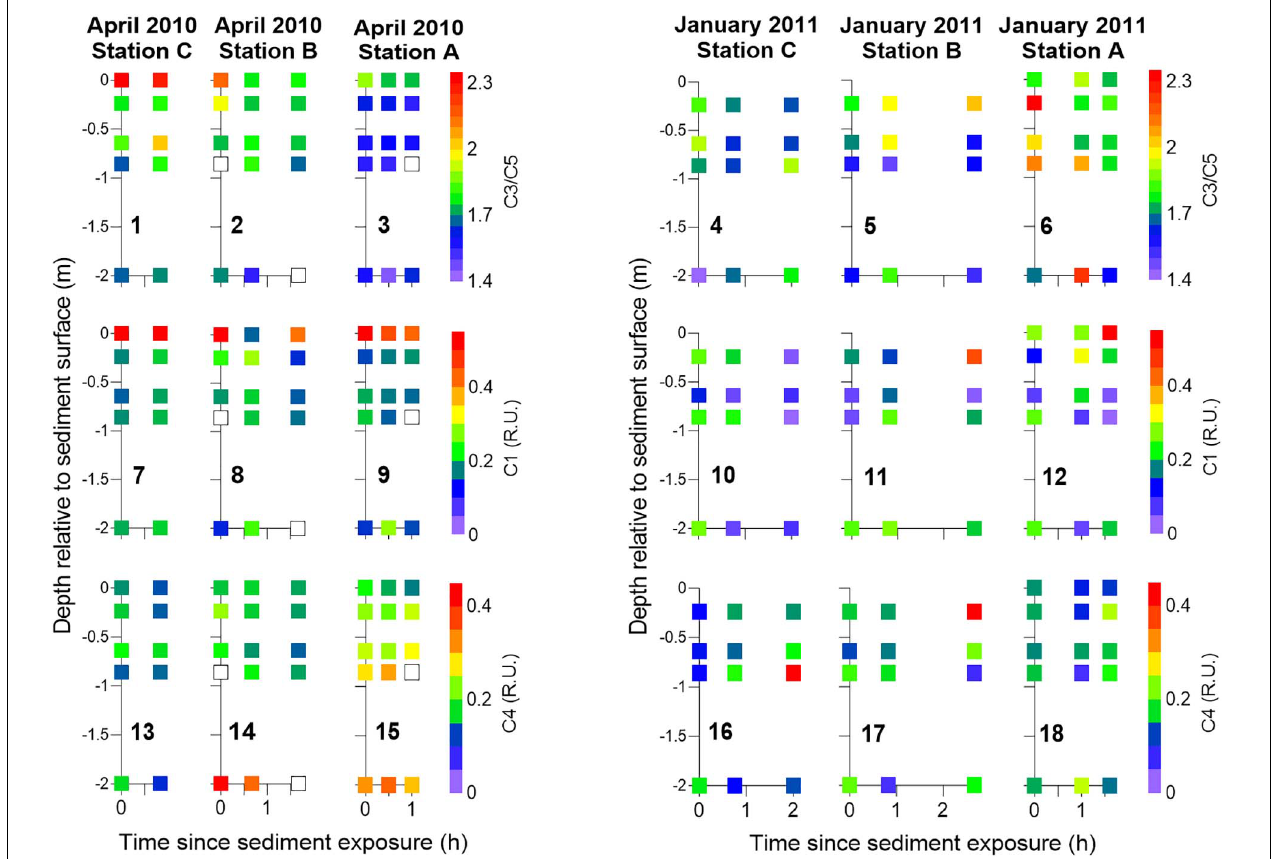
FIGURE 8 | Temporal FDOM distribution within the seepage face during the period of active seepage, i.e., during sediment exposure, organized by sampling station during April 2010 and January 2011. The ratio of FDOM C3/C5 (panels 1–6), C1 (panels 7–12), and C4 (panels 13–18) is shown. Samples were collected with piezometers and seepage meters. Seepage meter data corresponding to half an hour around the time of piezometer sampling were integrated at each sampling station and presented at the sediment surface. White squares represent lack of